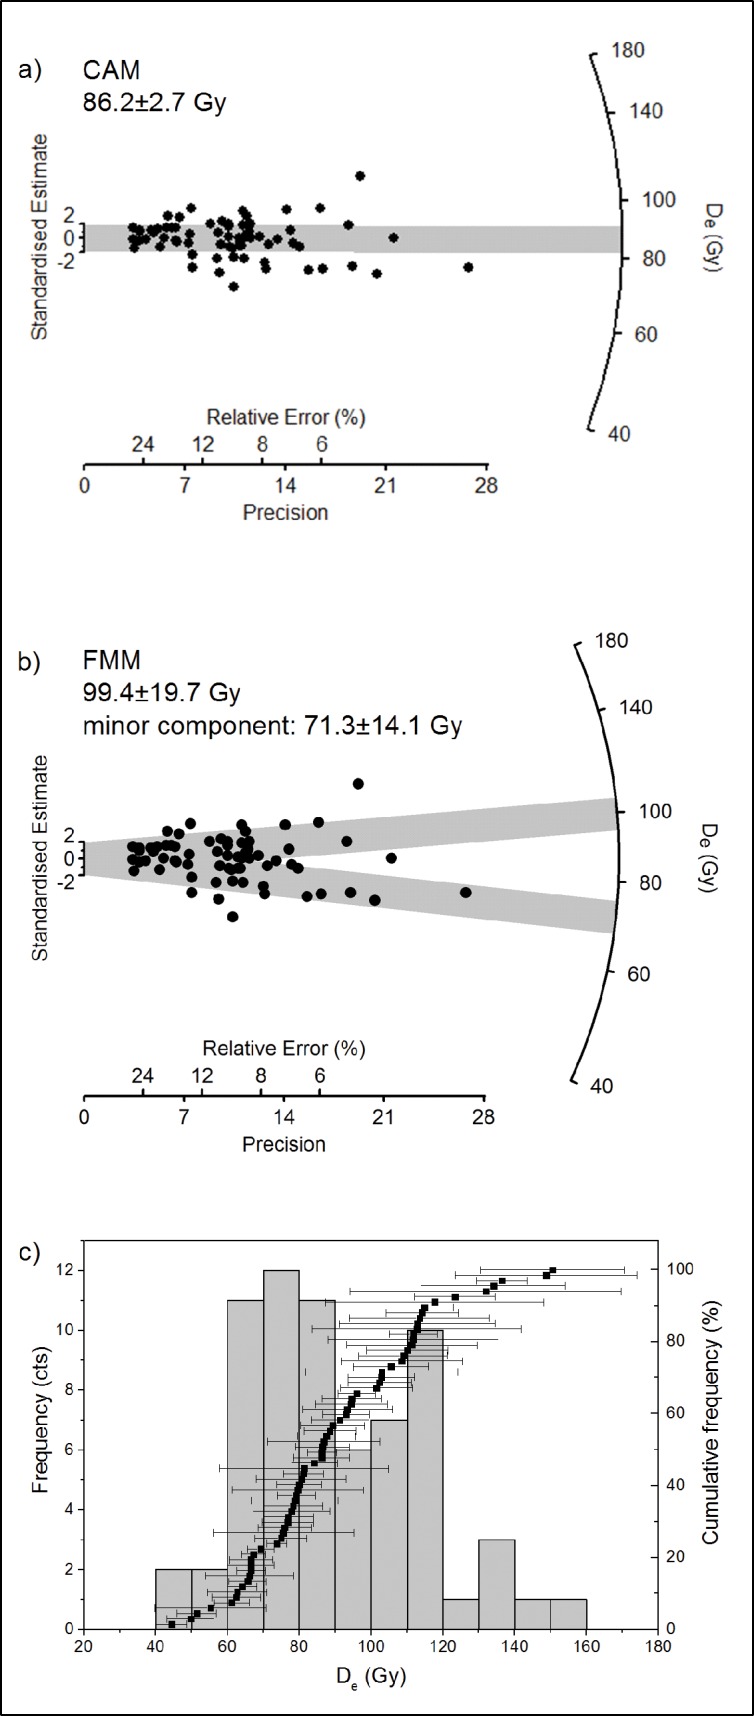
Dose distributions of single grain values obtained for sample L-EVA-1139.The shaded bands in the radial plots correspond to the standard error deviation from the De calculated using the (a) Central Age Model or (b) Finite Mixture Model. (c) Frequency histogram of single grain De values.